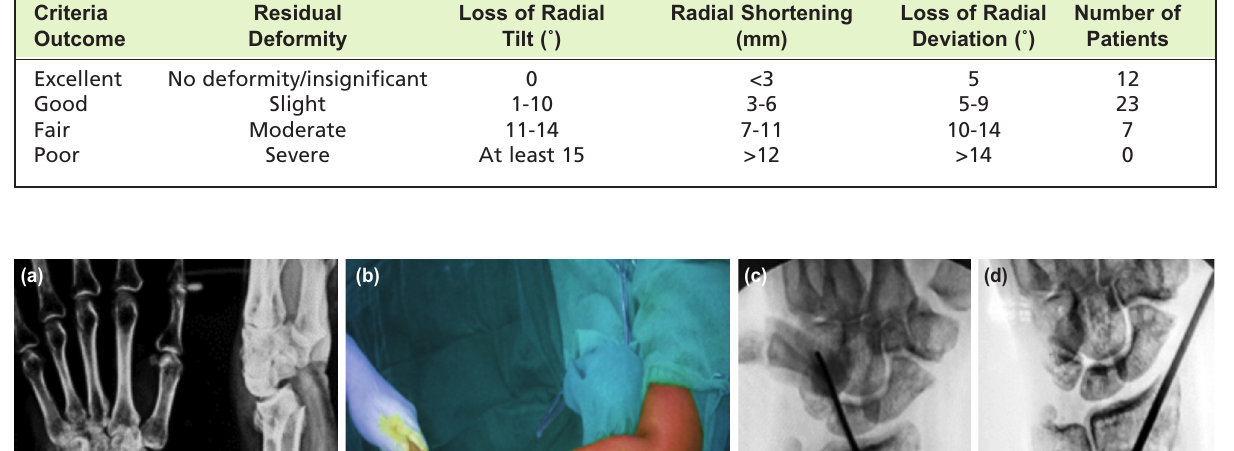
Evaluation and results using Sarmiento's modification of Lindstrom criteria Table II: